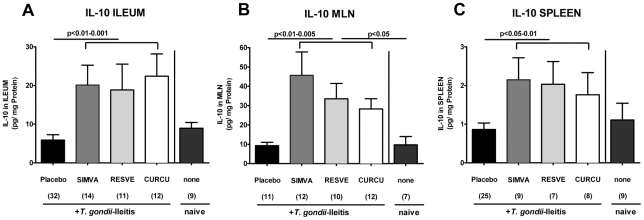
IL-10 concentrations (CBA-ELISA) in supernatants of Ileum (A), MLN (B) and spleen (C) cultures from naïve, uninfected animals and mice treated with Simvastatin (SIMVA), Resveratrol (RESVE) or Curcumin (CURCU) from d-2 until d8 p.i. as compared to Placebo controls (8 days after T. gondii infection).Numbers of analyzed animals are given in parentheses. Mean values, standard errors of the mean, and significance levels as indicated were determined by the Student's t test. Data are pooled from at least two independent experiments.